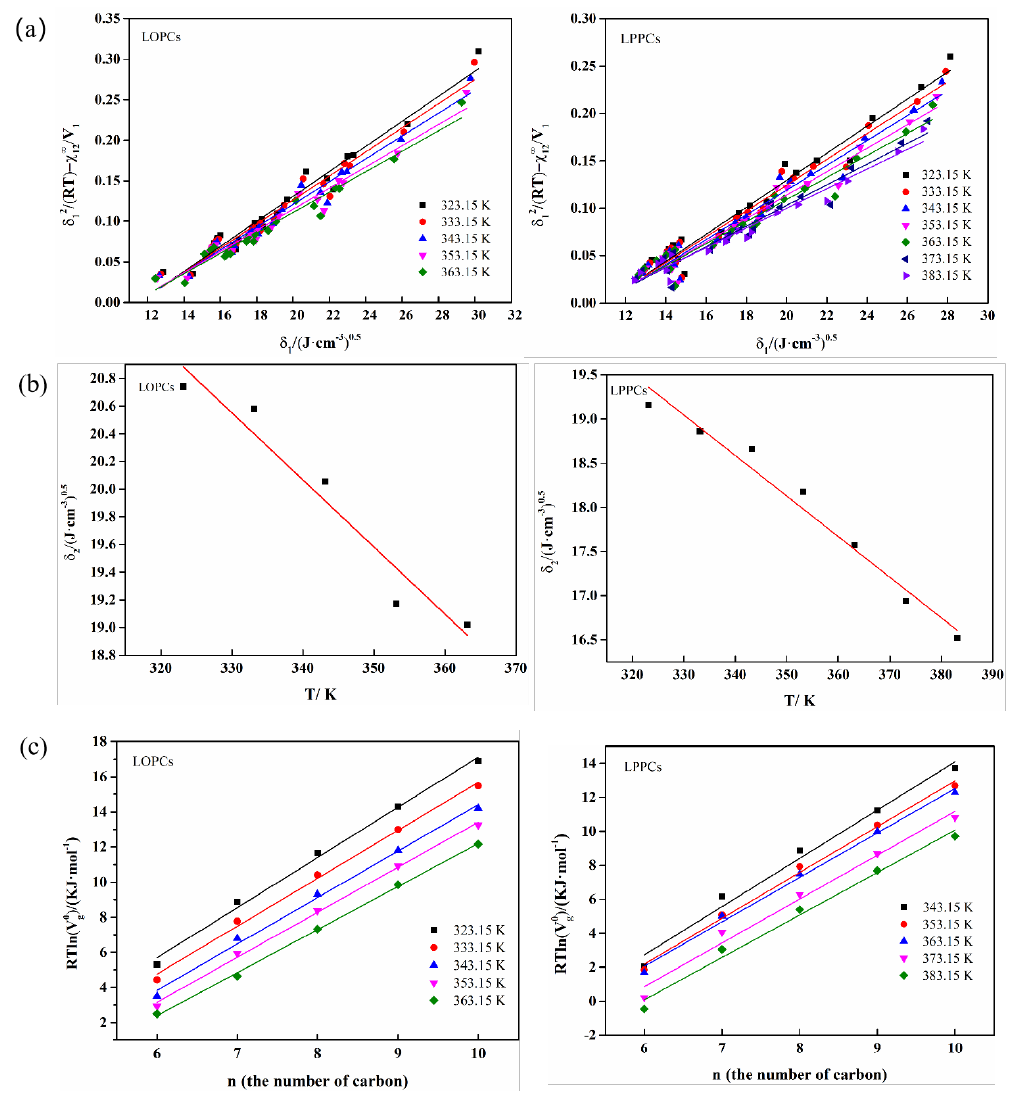
Figure 3. ( a ) Curves of 𝛿 vs. 𝛿 1 at different temperatures for polymeric proanthocyanidins and oligomeric proanthocyanidins; ( b ) Extrapolation to calculate solubility parameter δ 2 of proanthocyanidins at 298.15 K; ( c ) Variation of RTlnV N with number of carbon atoms in n-alkanes at different temperatures.